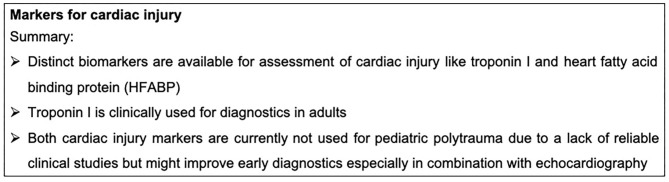
Summary box markers for cardiac injury.